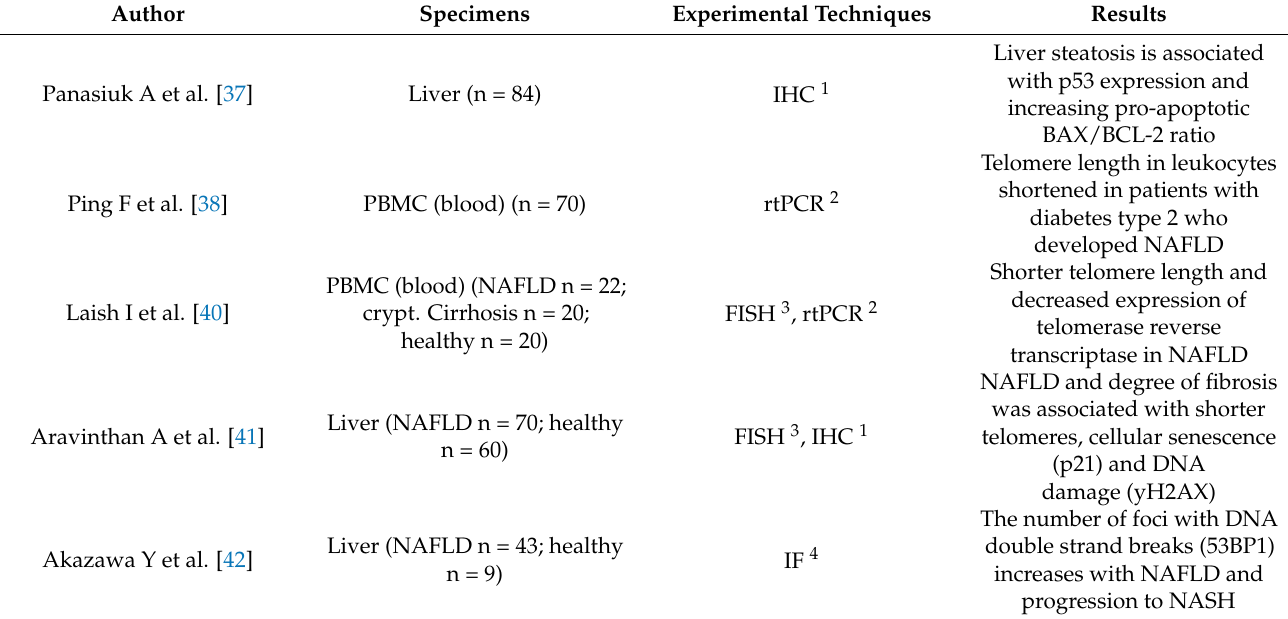
Table 1. Human studies exploring the phenotype of senescence in fatty liver